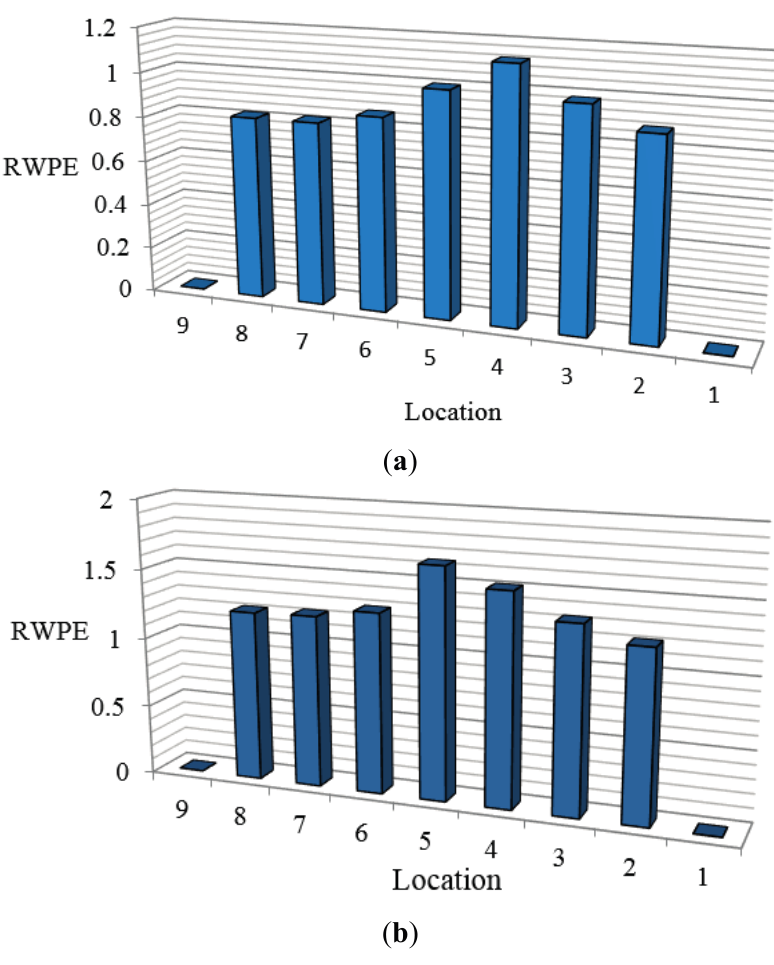
Figure 4. Histograms of RWPE: ( a ) Case 1; ( b ) Case